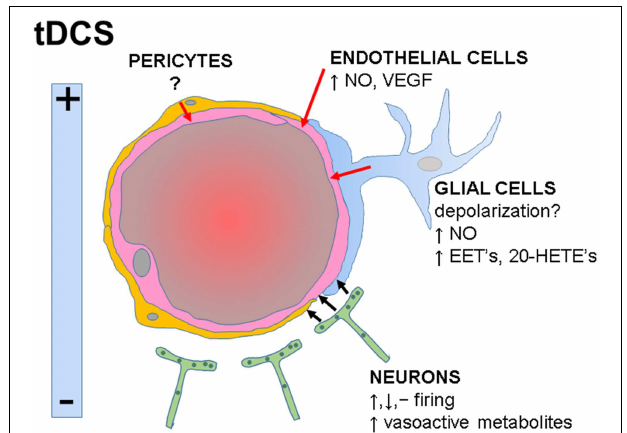
FIGURE 1 | Functional interactions within the neurovascular unit and potential influences of tDCS on specific cell types. tDCS-induced electrical fields may increase, decrease or have no effects on neuronal firing rates. Neuronal-derived metabolites directly or indirectly activate endothelial cells (black arrows), inducing vasodilatation. Potential direct effects of tDCS on glial, endothelial cells, and pericytes are indicated (red arrows). NO, nitric oxide; VEGF, vascular endothelial growth factor; EET’s, epoxyeicosatrienoic acids; 20-HETE’s, 20-hydroxyeicosatetraeonic